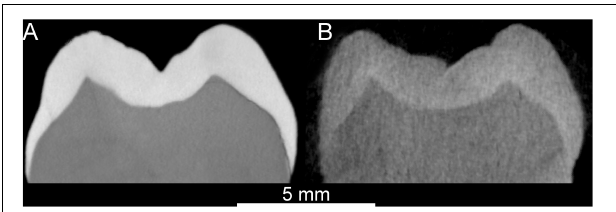
FIGURE 1 | Comparison between the X- µ CT- (A) and n- µ CT-based (B) virtual sections through the mesial cusps of a modern human maxillary M3. The enamel (light gray) – dentine (dark gray) boundary is distinctly traceable in both cases. The total acquisition times to scan the specimen were of 120 (cid:48) (X- µ CT) and 22 h (n- µ CT).